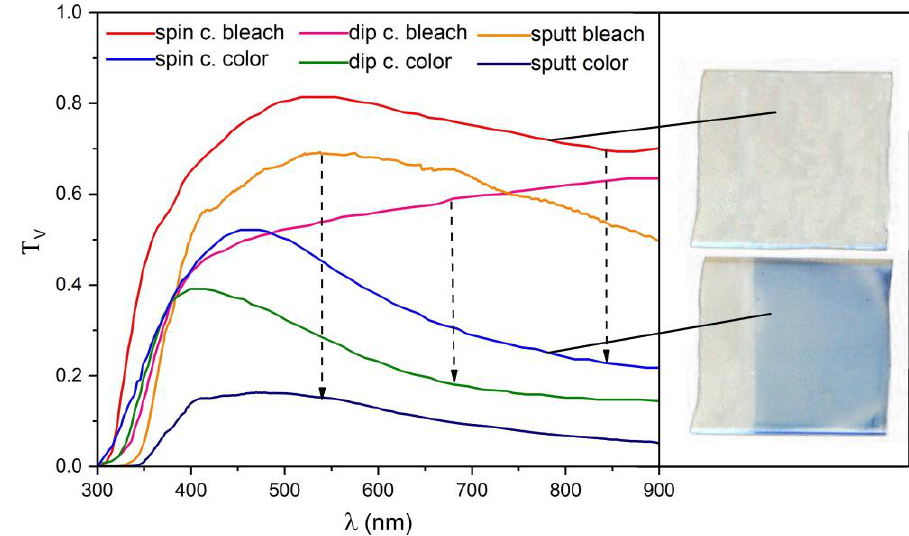
Figure 2. Optical transmittance spectra of the investigated EC devices in the bleached and colored states. A picture of the sample prepared by spin coating in two transmittance states is shown. Table 1. Calculated parameters. τ V = luminous transmittance; CR = contrast ratio; ( x , y , z ) = cromaticity coordinates; CIE CRI = color rendering index, CCT = correlated color